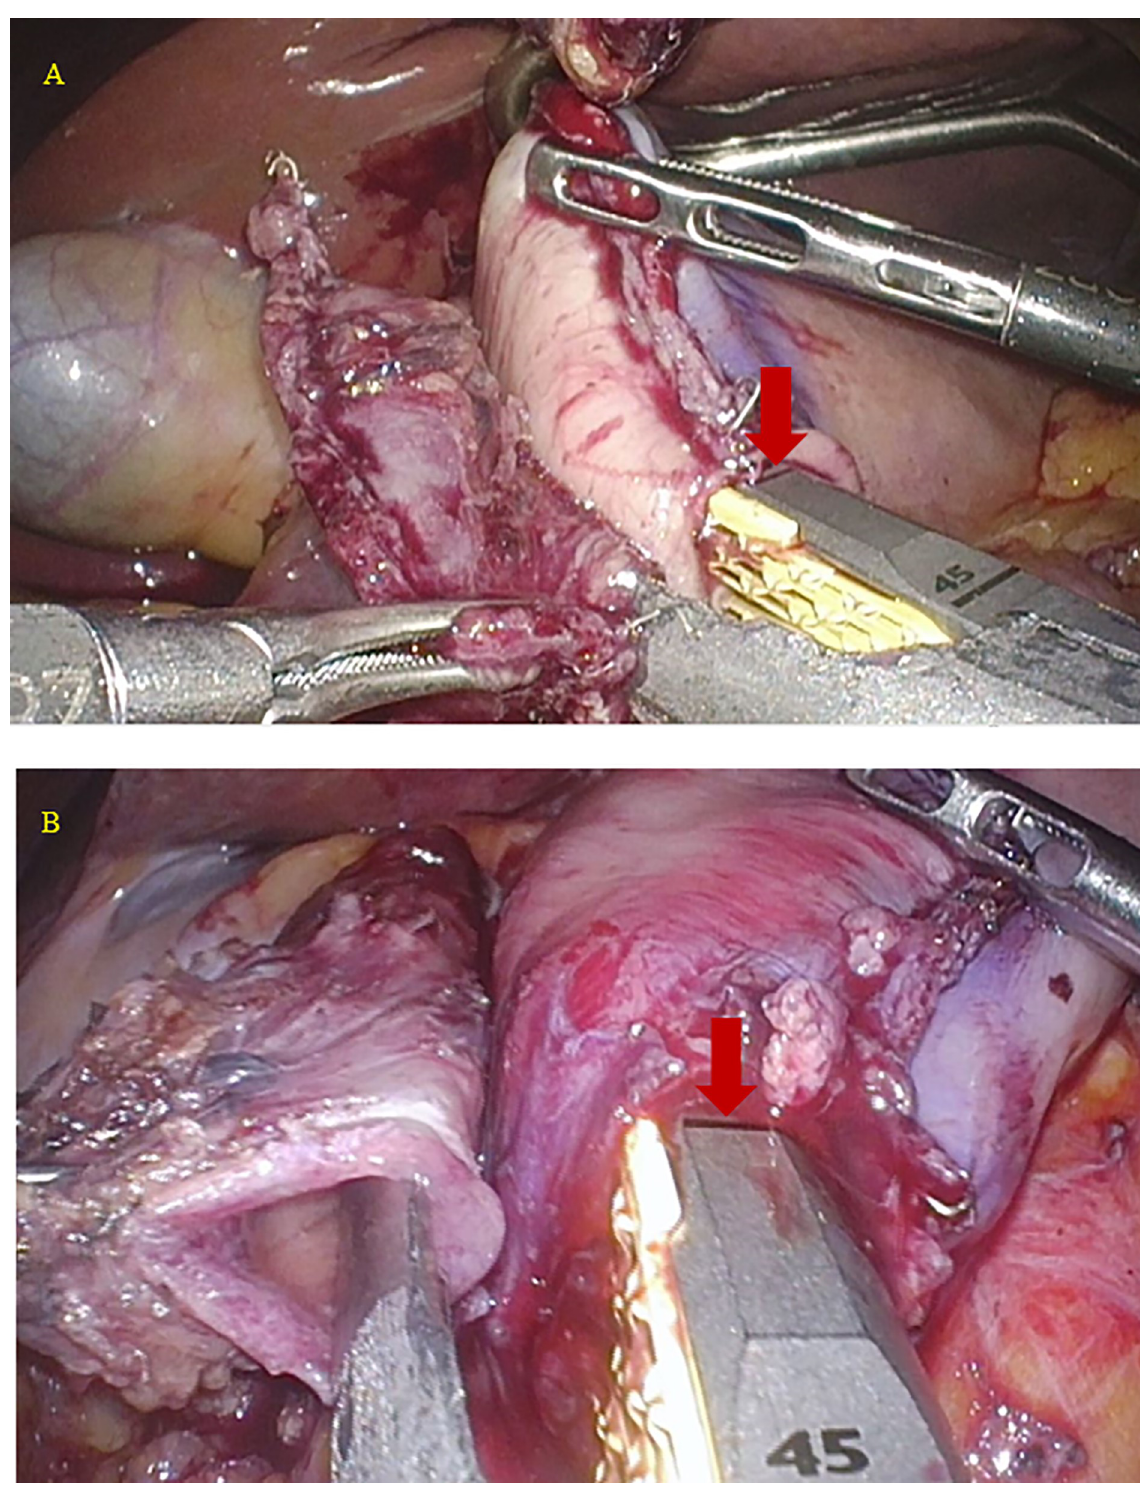
Fig 8. Linear stapling in the patients with a staple length of 30 mm. A Linear stapling in Case 31 (red arrow: 30-mm mark on the stapler). B Linear stapling in Case 35 (red arrow: 30-mm mark on the stapler).